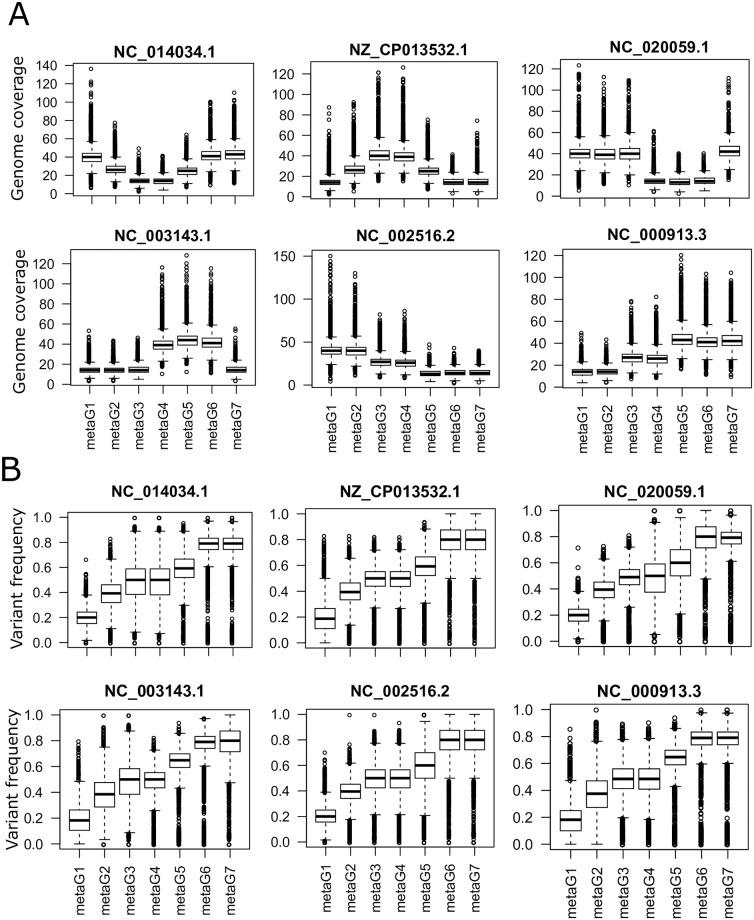
Simulated seven-metagenomic dataset on an admixture of six bacterial species containing within-species single nucleotide polymorphism.A. Variable loci genomic coverage distribution of the species. B. Within-species variants frequencies distribution.